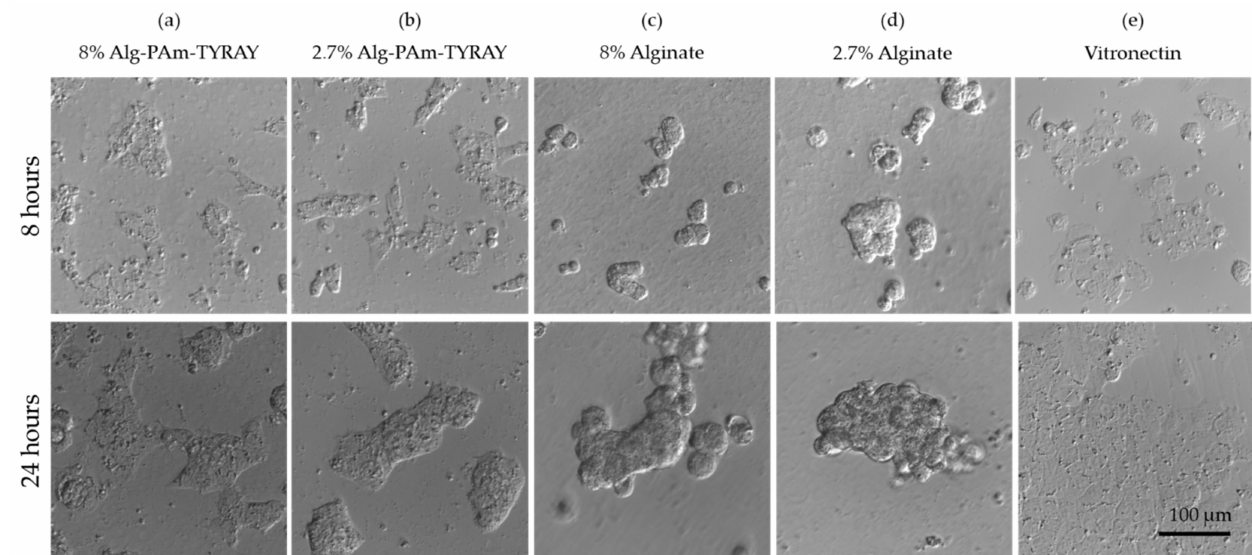
Figure 10. Adhesion and spreading of human embryonic stem cells (hESC) 8 h (top row) and 24 h (bottom row) after seeding on the surface of Alg-Pam-TYRAY ( a , b ) and alginate without modification ( c , d ). Solutions were prepared in concentrations 8% ( w / v ) ( a , c ) and 2,7% ( w / v ) ( b , d ). A positive effect of peptide included in alginates was observed on adhesion and wide spreading of hESCs similar to standard conditions of Vitronectin-coated tissue culture plastic ( e